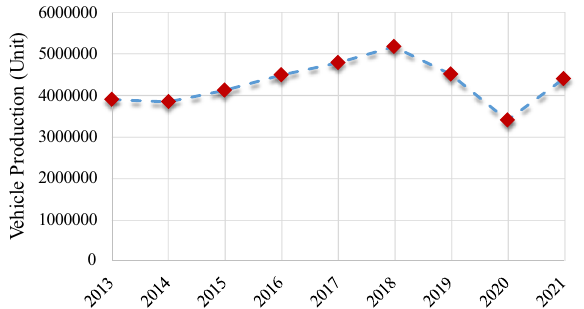
Figure 1. Automobile production per year in India from 2013 to 2021 (OICA 18